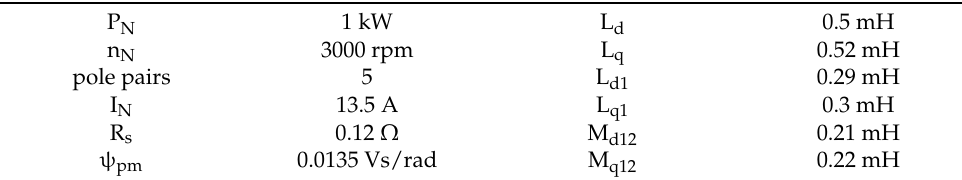
Figure 21. Setup used for the experimental verification. Table 1. Machine